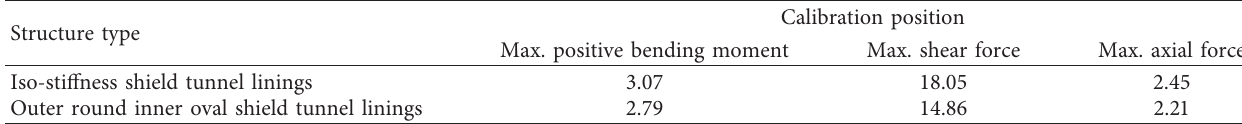
Table 5: Safety factor K